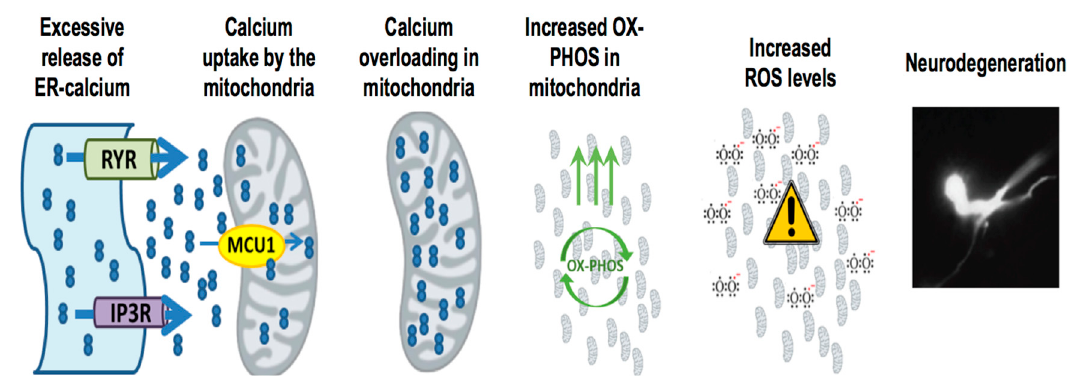
Figure 2. Presenilin mutations result in enhanced ER-mitochondria calcium transfer mediated neurodegeneration. Presenilin mutations result in excessive ER-calcium release, which causes the activation of mitochondrial calcium uniporter MCU-1 (mitochondrial calcium uniporter 1) and subsequent uptake of calcium into the mitochondria. With increased calcium uptake into the mitochondria, it stimulates mitochondrial respiration and increases ROS (reactive oxygen species) generation, resulting in neurodegeneration.